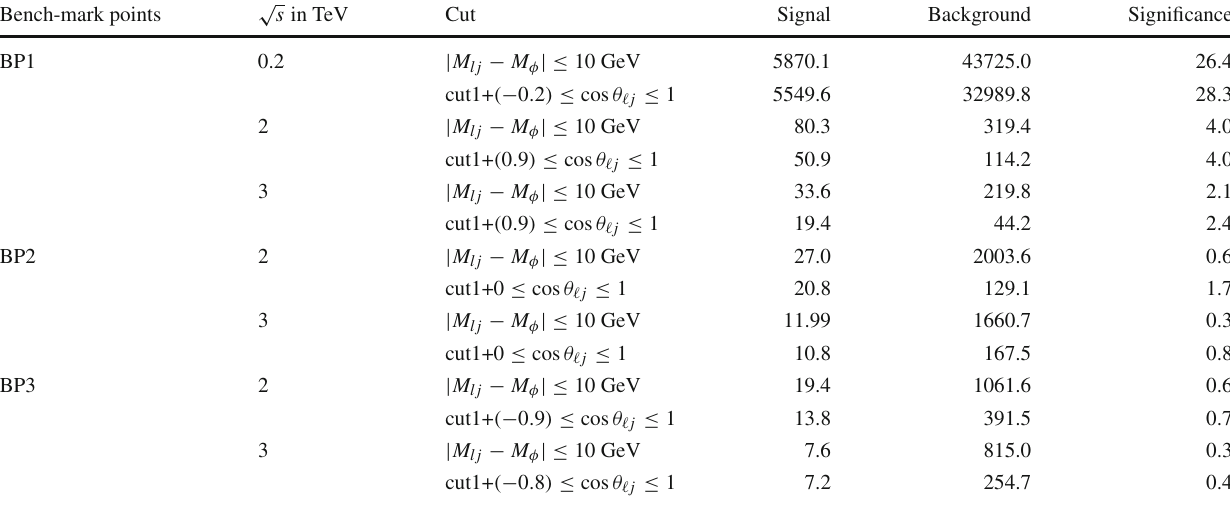
/ 3 ) c with luminosity 100 fb − 1 at e – γ collider 2